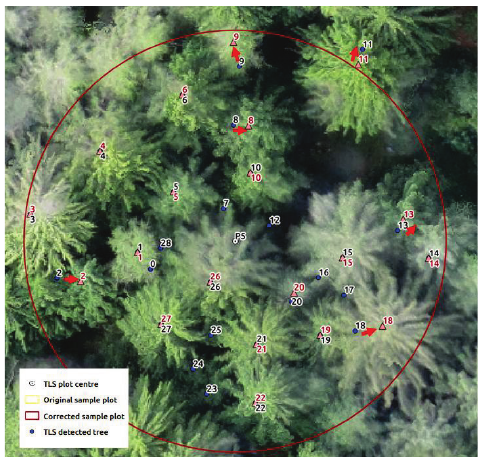
Figure 5. Matching between TLS detected trees (blue) and CHM trees detection